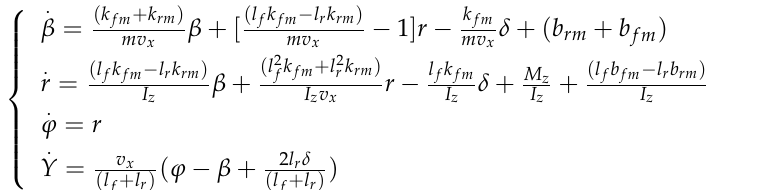
region of the PWA tire model.